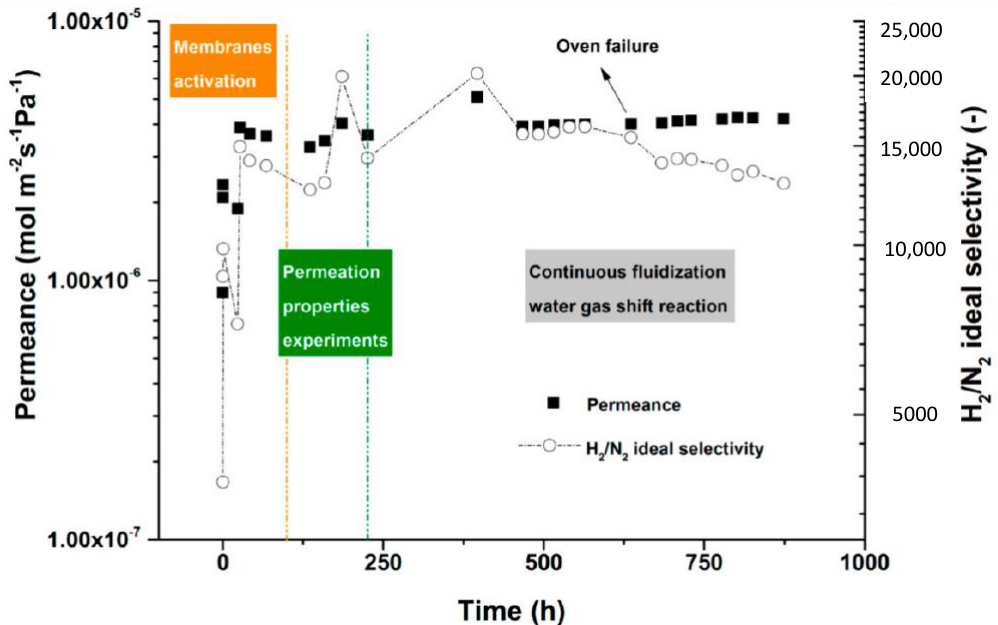
Figure 9. Long-term performance of the membrane module during 900 h of continuous operation in the bubbling fluidization regime at high-temperature WGS conditions. Reproduced from [37].